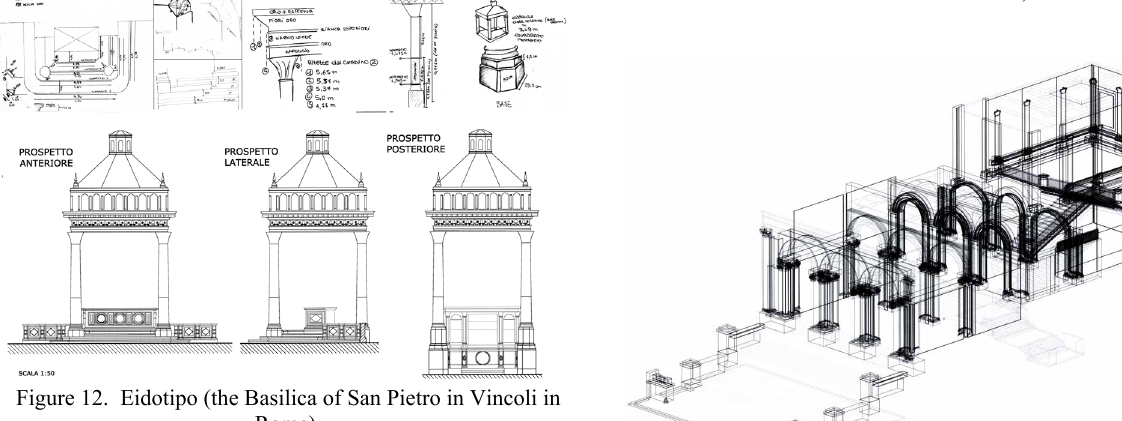
Figure 14. Axonometric View of the baldachin (Basilica of San Pietro in Vincoli in Rome).